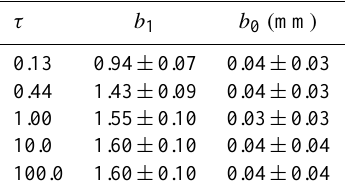
Table 2. Fit parameters and standard errors for a linear regression for all samples between the optimal SHS diameter and the optical diameter if the optimization of ˆ d τ is done for prescribed τ according to Eq.